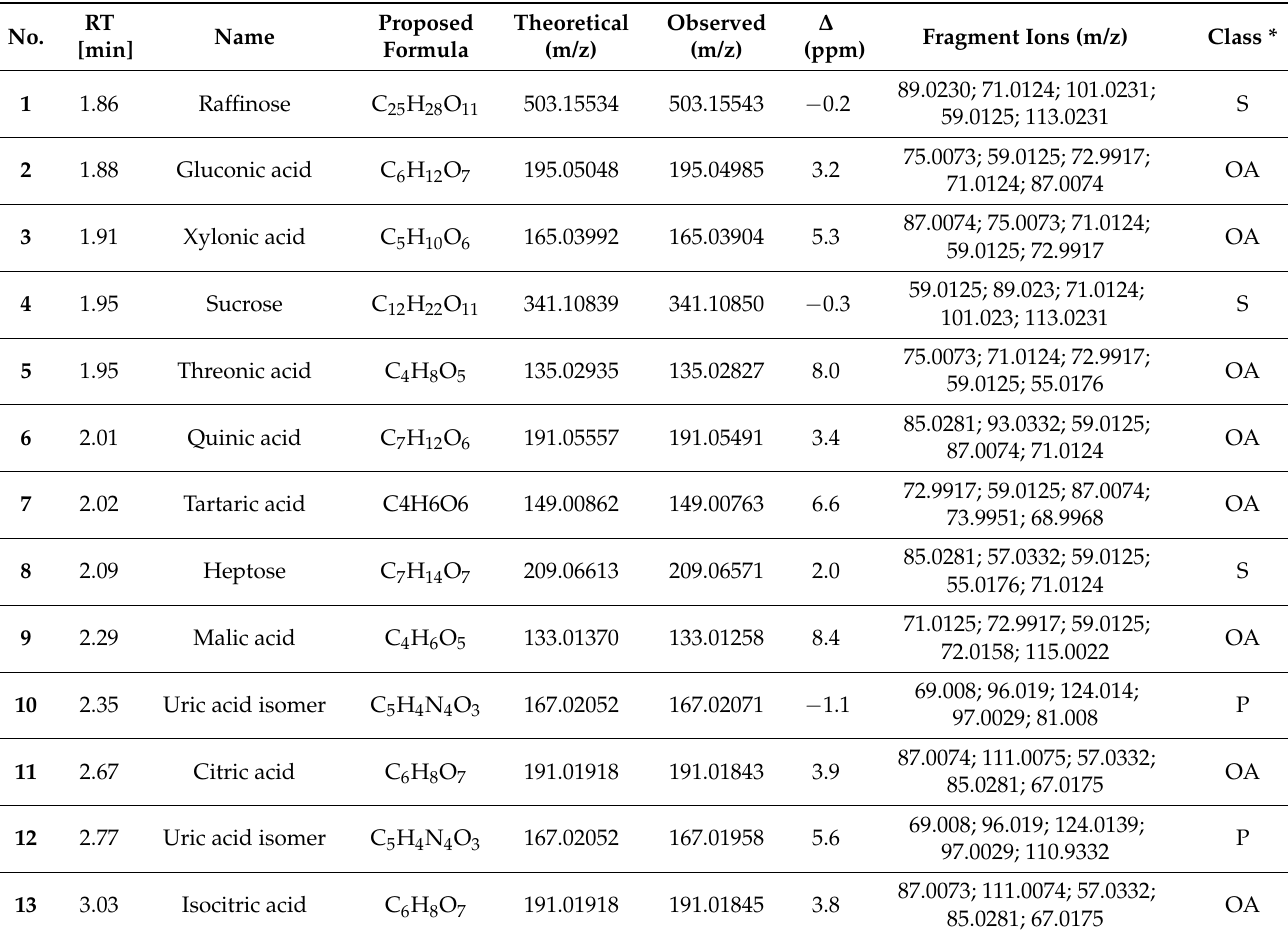
Table 1. Retention times (RT, min), proposed formulas, experimental m/z, accuracy ( ∆ , ppm) and main diagnostic experimental product ions of the major compounds identified by LC-Q-Orbitrap HRMS in seed, sprout, leaf, flower and herb extracts of S. hispanica in ESI( −